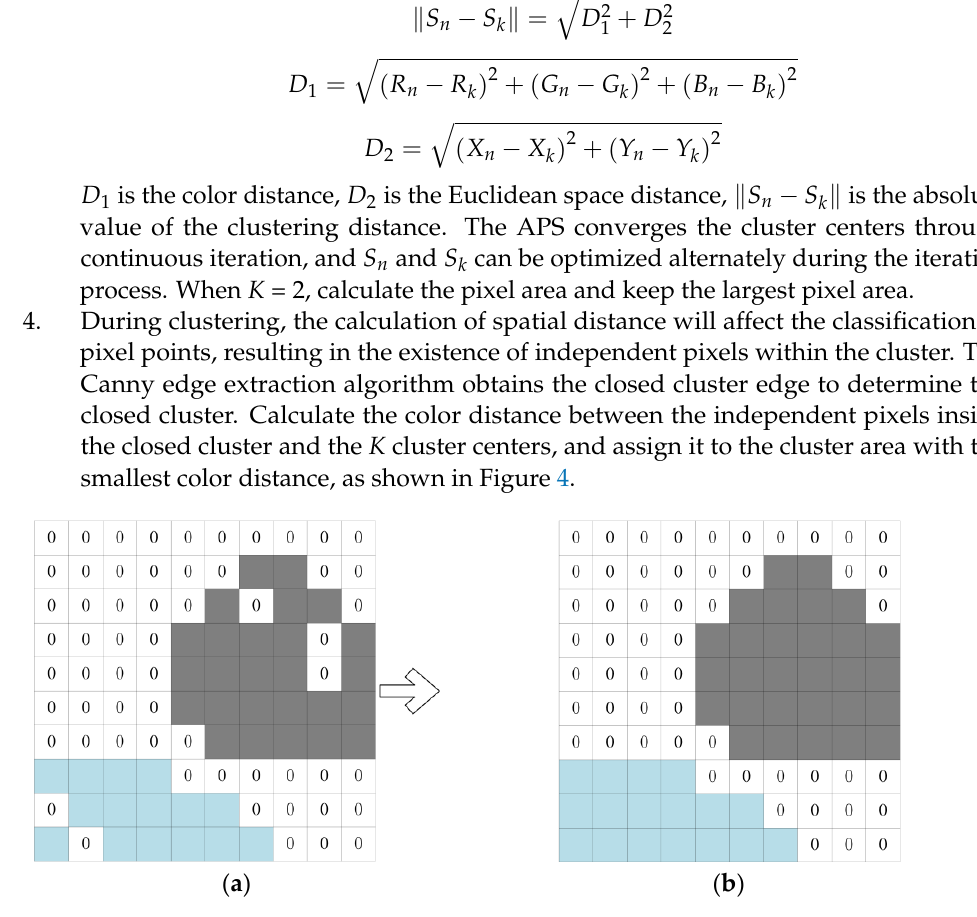
Figure 4. Classification of independent pixels within the cluster. ( a ) Obtaining the color distance for independent pixels. ( b ) The classification of independent pixels.